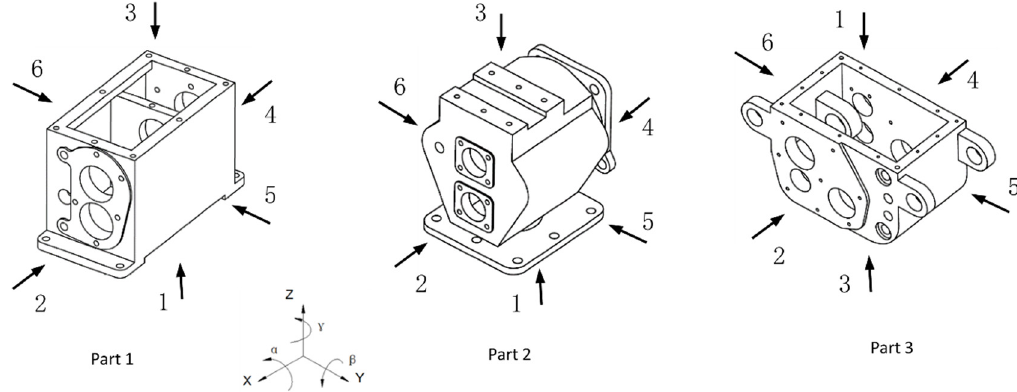
Figure 13. A gearbox part family of three parts.